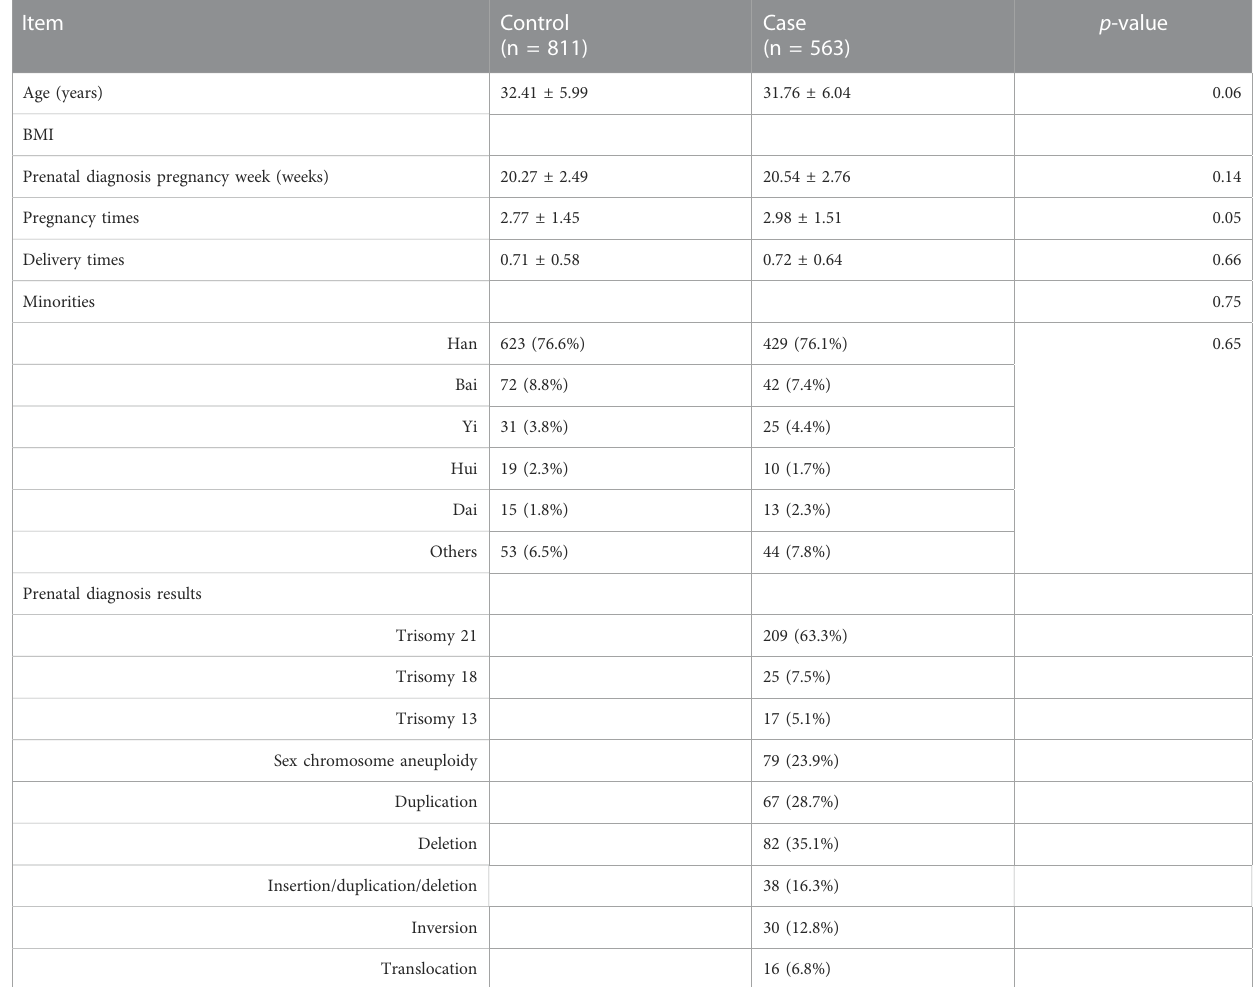
TABLE 1 Characteristics of study subjects for cases and controls.